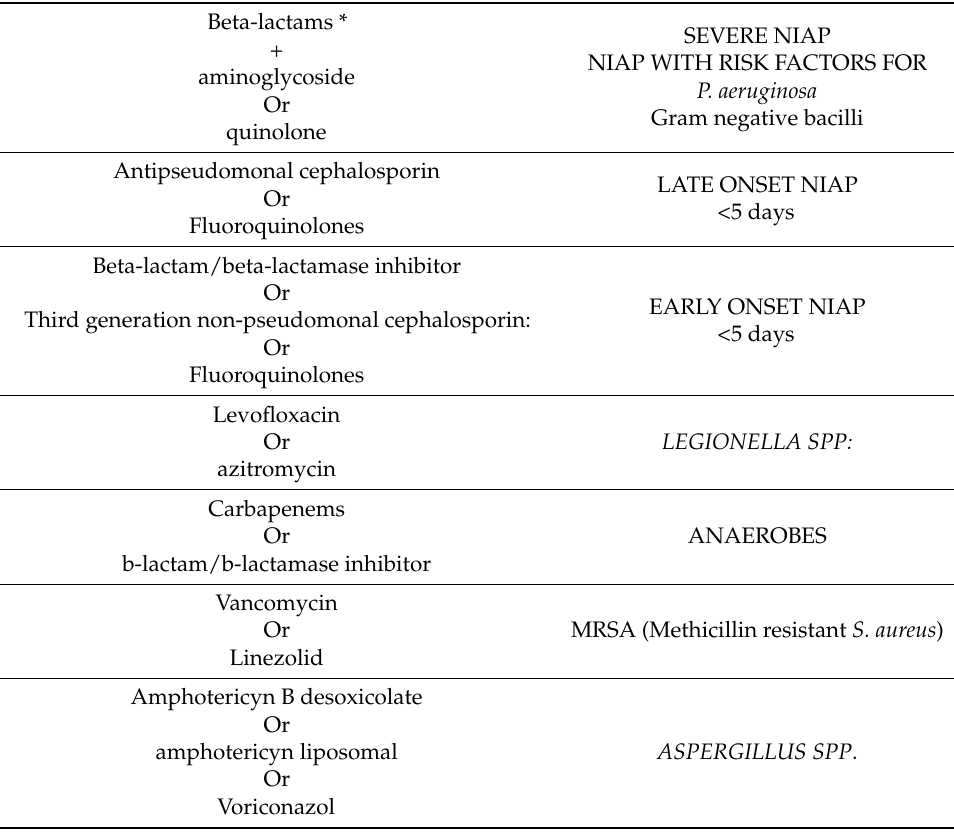
Table 3. Treatment of non ICU-acquired pneumonia